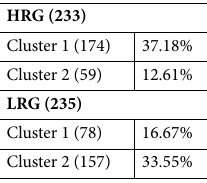
Table 4. The relationship between risk groups and